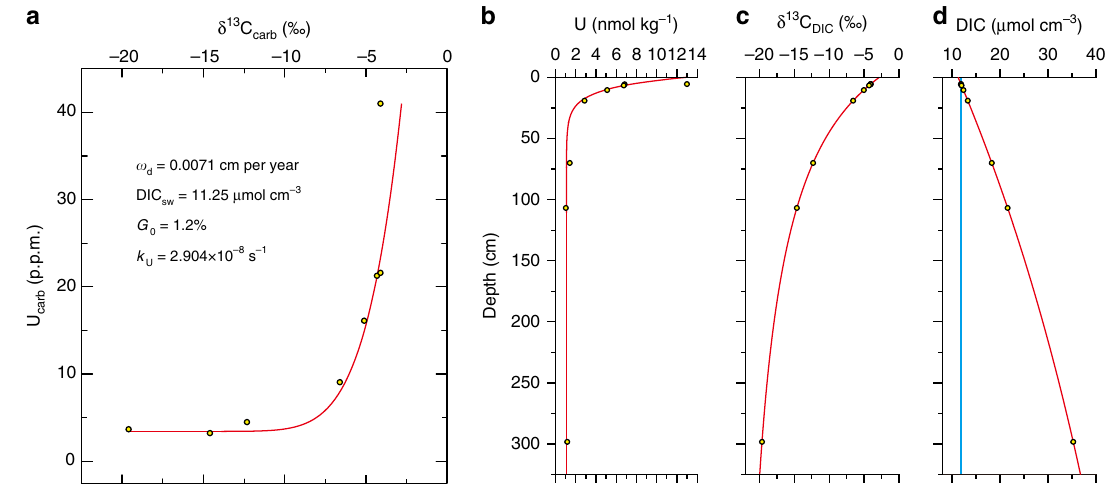
Figure 4 | Modelled variations of authigenic carbonate compositions and chemical profiles of pore water. The sample in the model corresponds to line b in Fig. 3. ( a ) A modelled co-variation of d 13 C carb and U carb . ( b – d ) Modelled pore water profiles of uranium and DIC concentrations and d 13 C DIC . The blue line in d shows the DIC concentration at which the authigenic calcite started to grow. The calcite-pore water partition coefficient of uranium is 13.25, with the assumption that the uranium and calcium concentrations of the pore water corresponding to the earliest authigenic calcite are the same as those of modern ocean water (13nmolkg (cid:2) 1 and 0.01molkg (cid:2) 1 , respectively). See Supplementary Table 6 for the values/ranges of all parameters in the